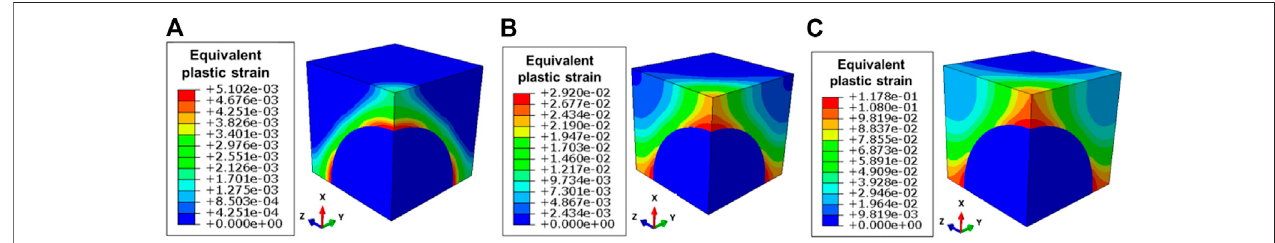
Frontiers in Materials |